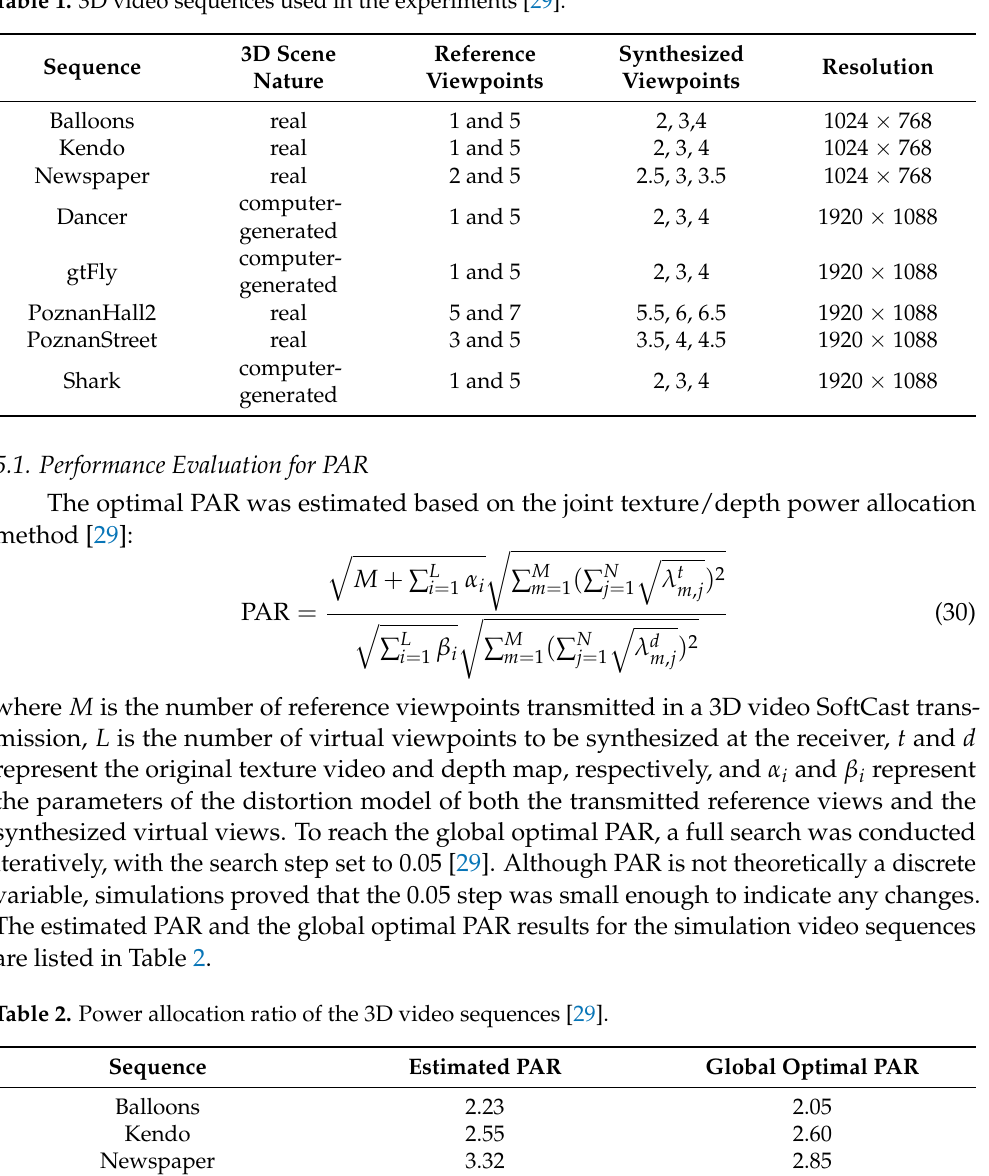
Table 1. 3D video sequences used in the experiments [29].